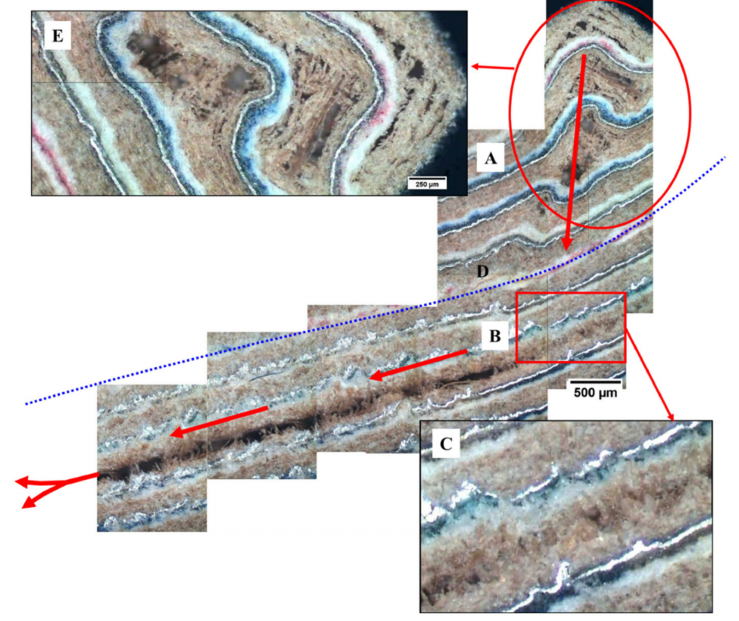
Figure 21. Example of mechanism of failure in the flexion of the multilayer sample of G4 series. ( A ) Generation of a lack of cohesion-defibrillation zone of the cellulose with progression to centre of the board. ( B ) Defibrillation into cellulose, the weakest zone of this type of board. The interface PE–PE or neutral layer ( D ) of the centre of the board remains intact (in all the tests) and the stress is transferred to the second or third sheet from the surface board. ( C ) Detail with the initial defibrillation in the third sheet, into cellulose. ( E ) Detail of the lack of cohesion-defibrillation zone of the cellulose before progression to board